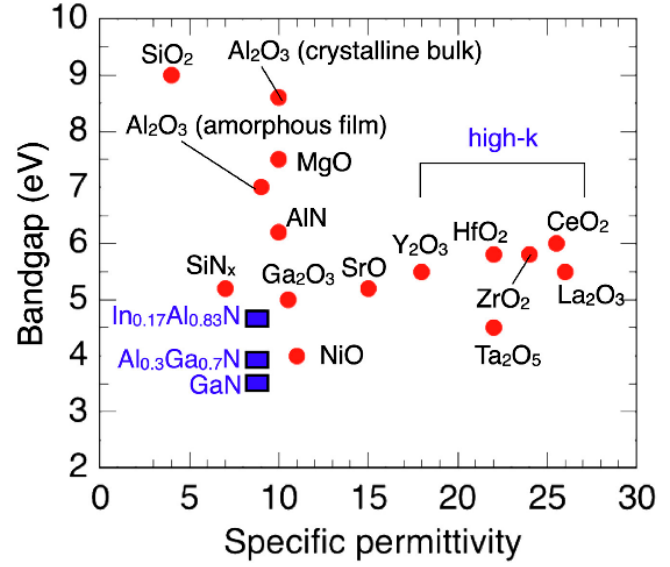
Figure 16. Band gaps and permittivity relationships for key insulators and GaN-based materials. Reprinted with permission from ref. [211]. Copyright 2018 Elsevier.